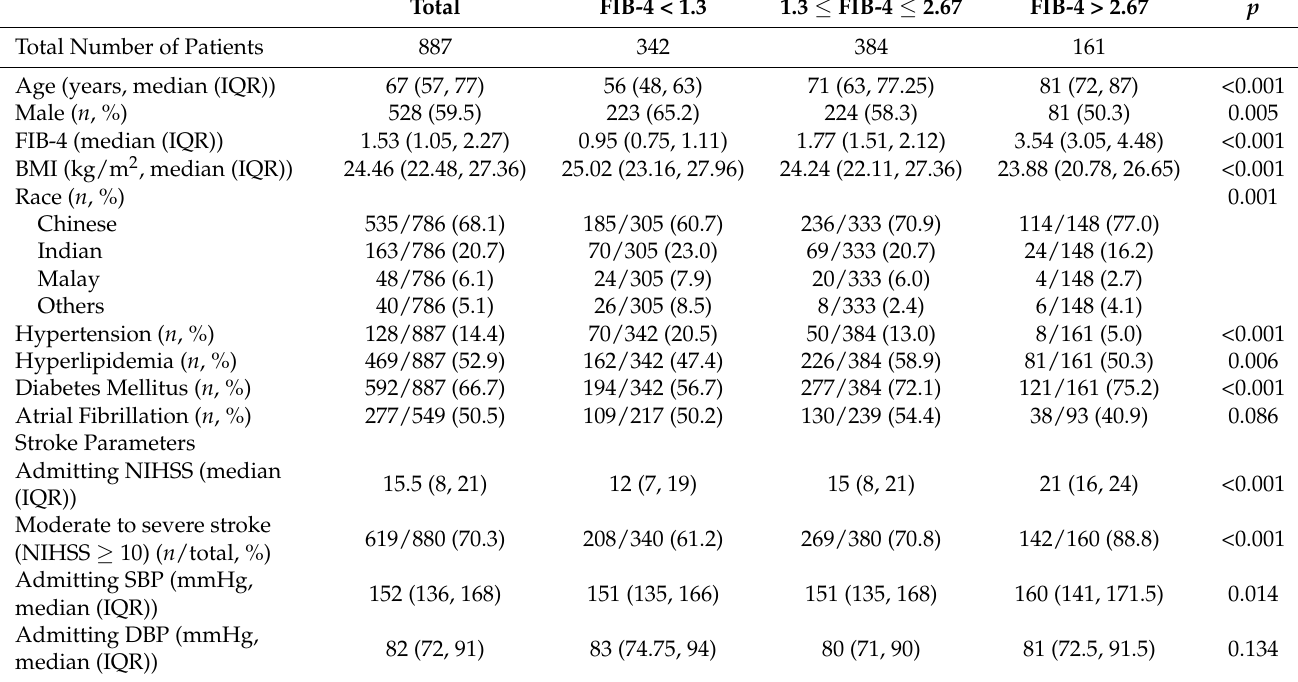
Table 1. Baseline Characteristics of patients, stratified according to FIB-4 cut-offs. Total FIB-4 <